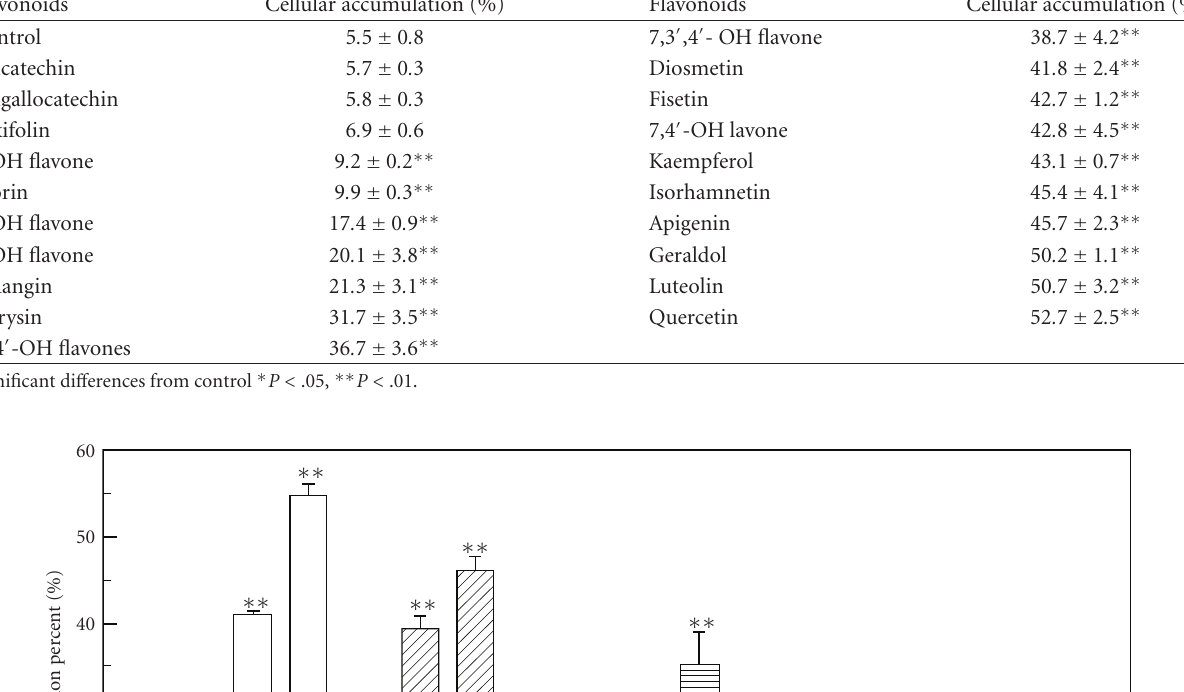
Table 2: The cellular accumulation percent of in N -acetyl 5-aminosalicylic acid Caco-2 cells. Caco-2 cells grown in tissue culture dishes were incubated with 200 μ M 5-ASA for 2 hours in the presence of flavonoids at the concentration of 100 μ M. Cellular accumulation percent: (cells/cells plus medium) × 100. Each value represents the mean ± SD of four to five experiments. Flavonoids Cellular accumulation (%) Flavonoids Cellular accumulation (%)